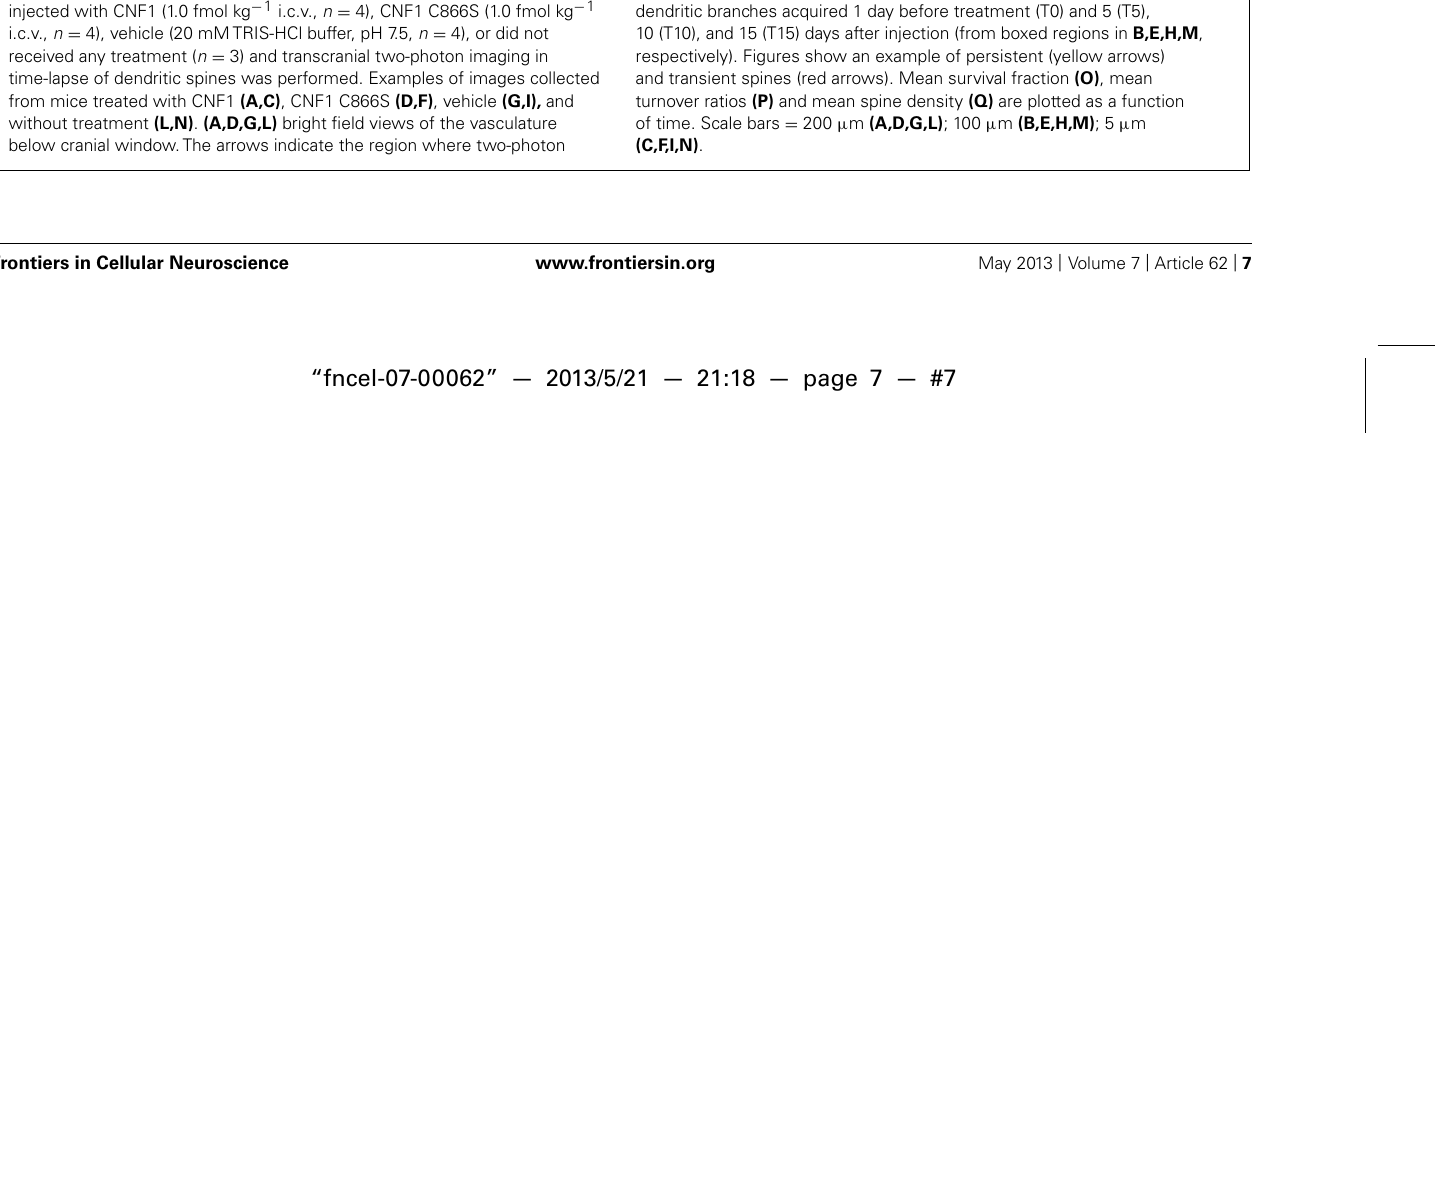
FIGURE 3 | Rho GTPase activation does not increase spine density and turnover in apical dendrites of primary visual cortex. GFP-m mice were injected with CNF1 (1.0 fmol kg − 1 i.c.v., n = 4), CNF1 C866S (1.0 fmol kg − 1 i.c.v., n = 4), vehicle (20 mMTRIS-HCl buffer, pH 7.5, n = 4), or did not received any treatment ( n = 3) and transcranial two-photon imaging in time-lapse of dendritic spines was performed. Examples of images collected from mice treated with CNF1 (A,C) , CNF1 C866S (D,F) , vehicle (G,I), and without treatment (L,N) . (A,D,G,L) bright field views of the vasculature below cranial window.The arrows indicate the region where two-photon